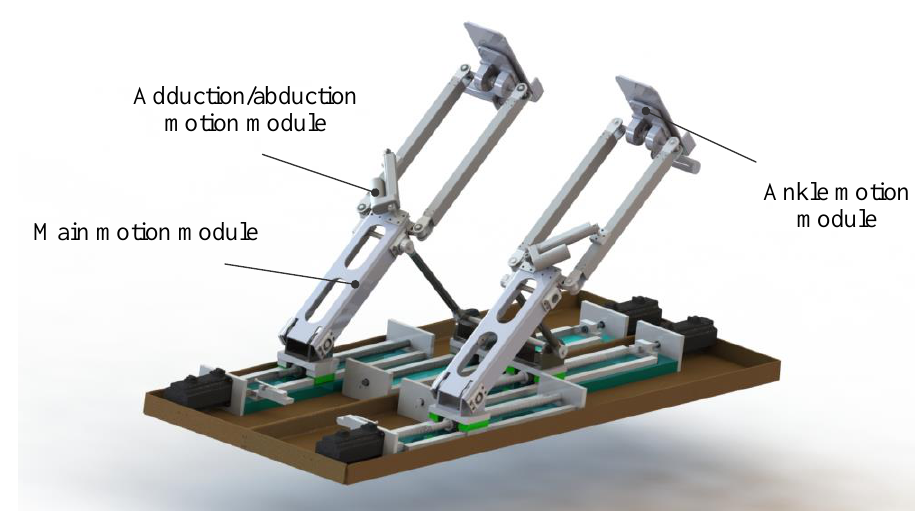
Figure 1. 4-DOF (degrees of freedom) spatial workspace lower limb rehabilitation robot.